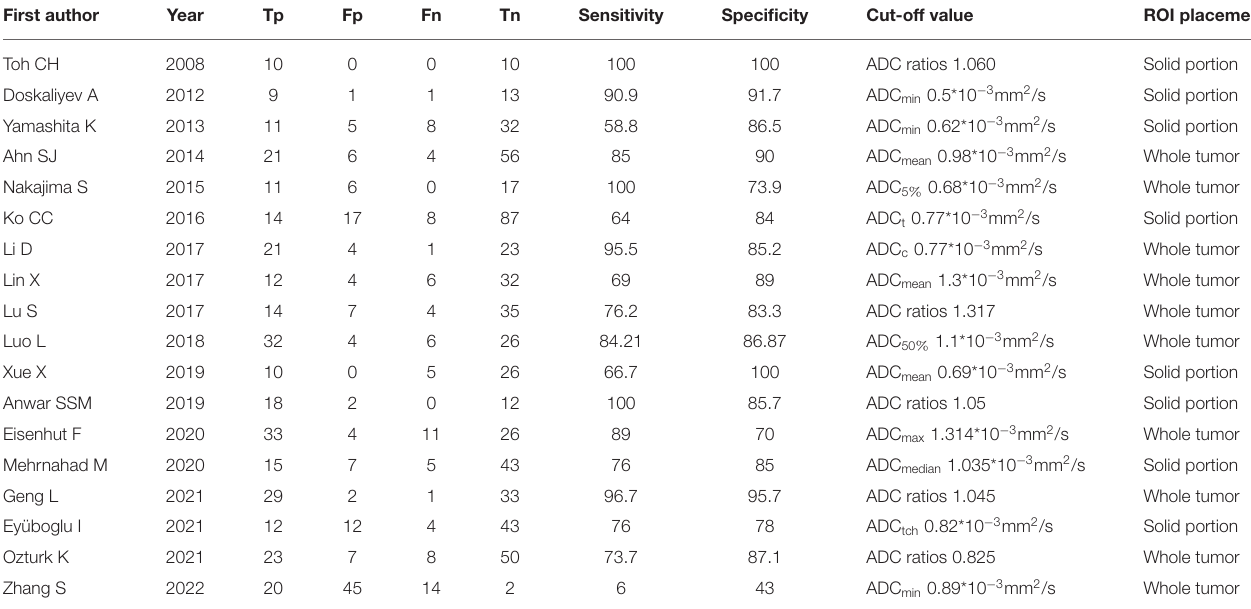
TABLE 2 | Characteristic of primary diagnostic